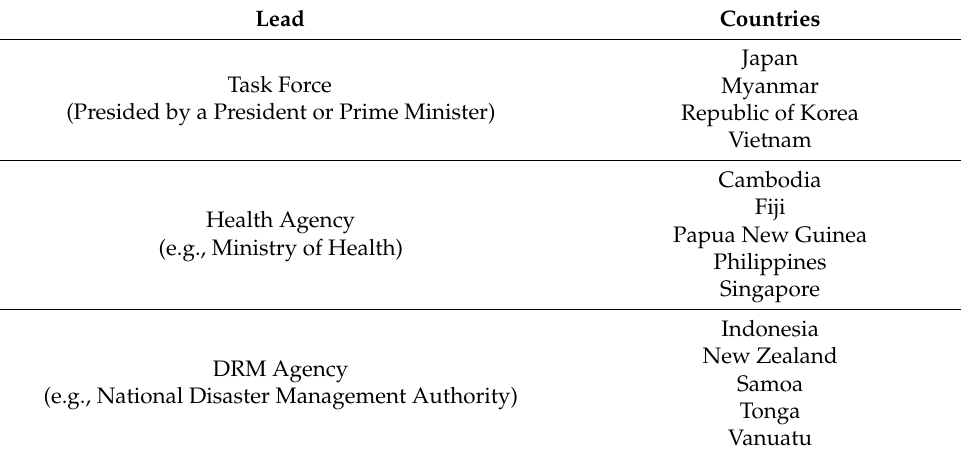
Table 1. Intragovernmental arrangements to COVID-19